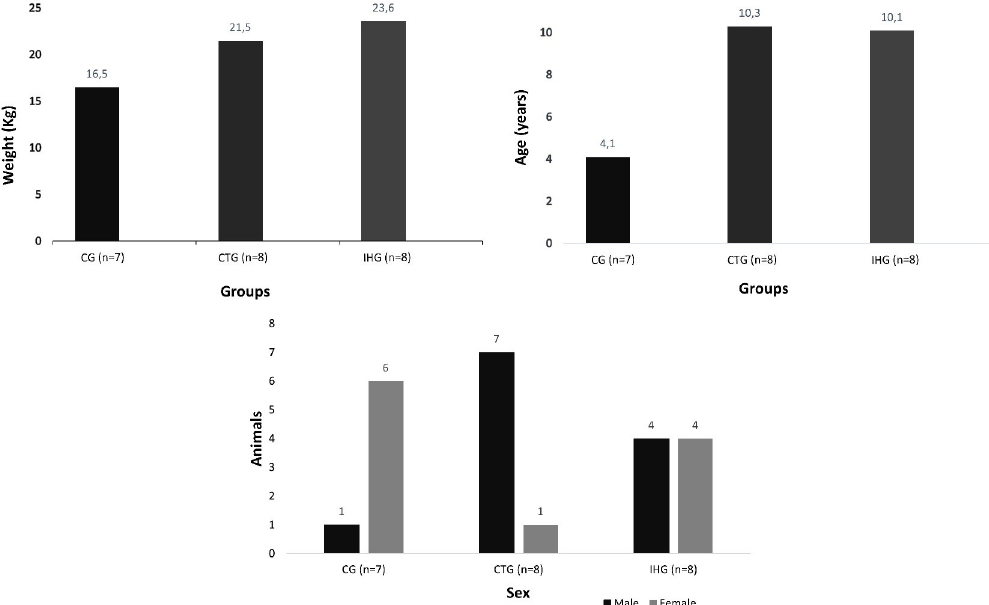
Fig 3. Data on sex and mean of weight and age values of clinically healthy animals (CG) and stage IV CKD dogs treated with intermittent hemodialysis (IHG) and clinical treatment (CTG).